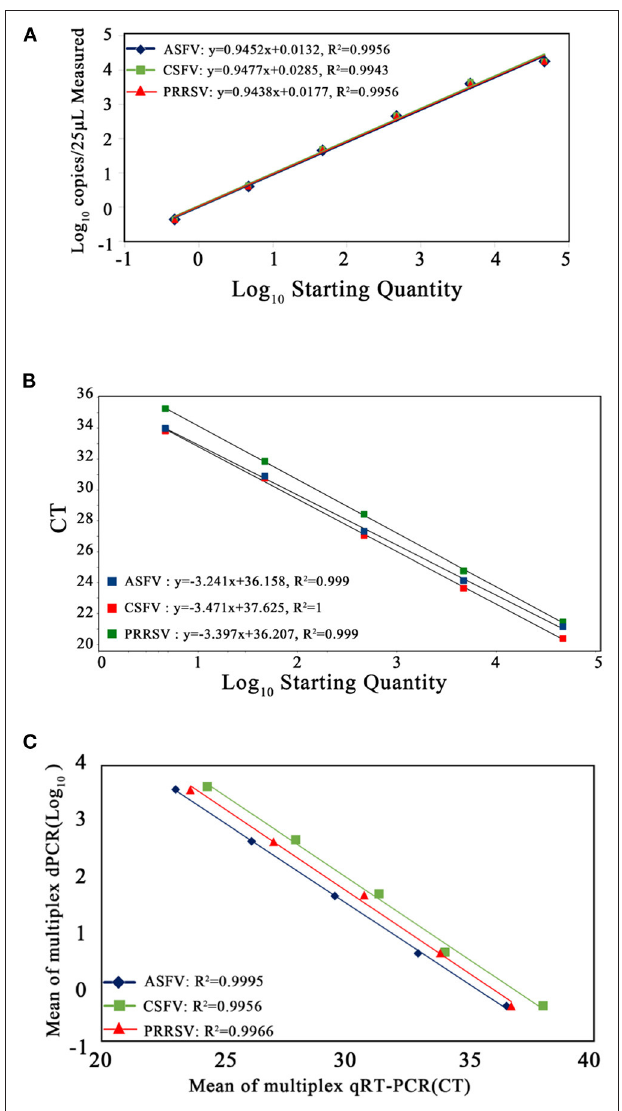
FIGURE 4 | Standard curves of the multiplex crystal dPCR (A) , the multiplex qRT-PCR (B) , and the correlation between these two methods (C) . The 10-fold serially diluted p-ASFV, p-CSFV and p-PRRSV standard plasmids from 4.69 × 10 4 to 4.69 × 10 − 1 copies/ µ l were used to generate the standard curves. The correlation between these two methods was acquired by plotting the logarithm of absolute measured values of the multiplex crystal dPCR against the logarithm of cycle threshold (Ct) values of the multiplex